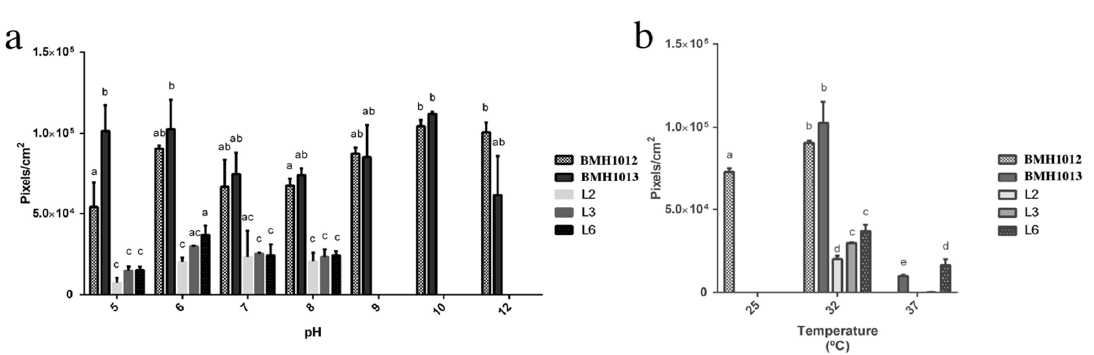
Figure 3. pH and temperature tolerance of the isolated strains. BMH1012 and BMH1013 are the yeasts isolates while L2, L3, and L6 are bacteria isolates. (a) Growth at different pH values of the indicated strains (b) Growth at different temperatures of the indicated strains. Letters indicate levels of statistical differences. ANOVA p value < 0.05.